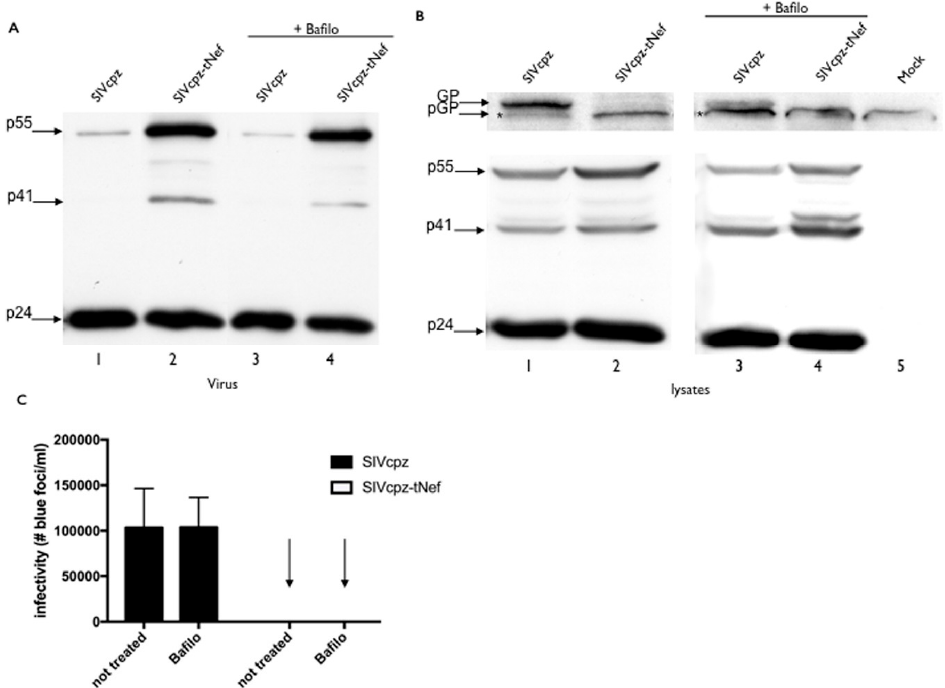
Figure 6. Inhibition of lysosomal degradation does not rescue SIVcpz-tNef GagPol levels and infectivity. ( A ) Hek-293T cells were transfected with SIVcpzWT and SIVcpz-tNef clones. After 24 h, the culture medium was replaced, and 50 nM of bafilomycin diluted in DMSO or DMSO alone as the control was added. After 24 h, supernatants and lysates were collected; ( A ) Western blotting with polyclonal α -p24 of viral lysates showing the accumulation of Gag in SIVcpz-tNef treated and non-treated viruses; ( B ) Cell lysates showing full-length (GP) and partially-processed (pGP) GagPol (top panel); Gag, p41 and p24 (bottom panel); ( C ) Infectivity assays of normalized supernatants. Results are the average of three independent experiments. * Asterisk indicates a non-specific band.